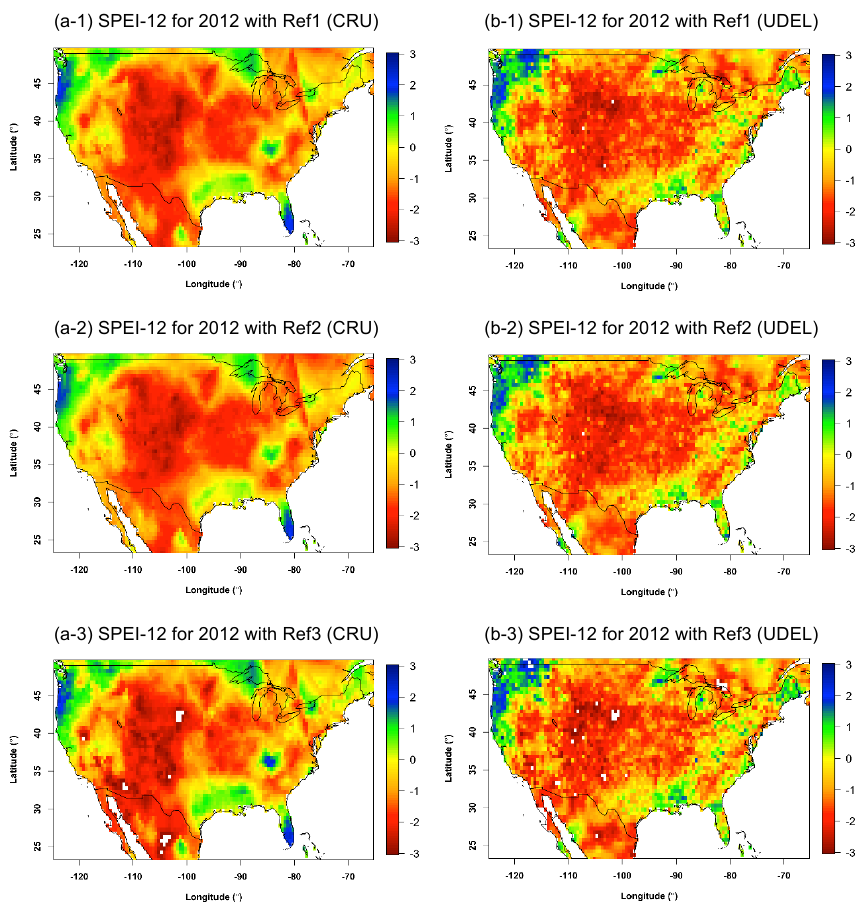
Figure 15. Spatial distribution of SPEI-12 for three different reference periods (Ref1, Ref2 and Ref3 in Table 2) based on the (a) CRU and (b) UDEL datasets in the United States in 2012 as an